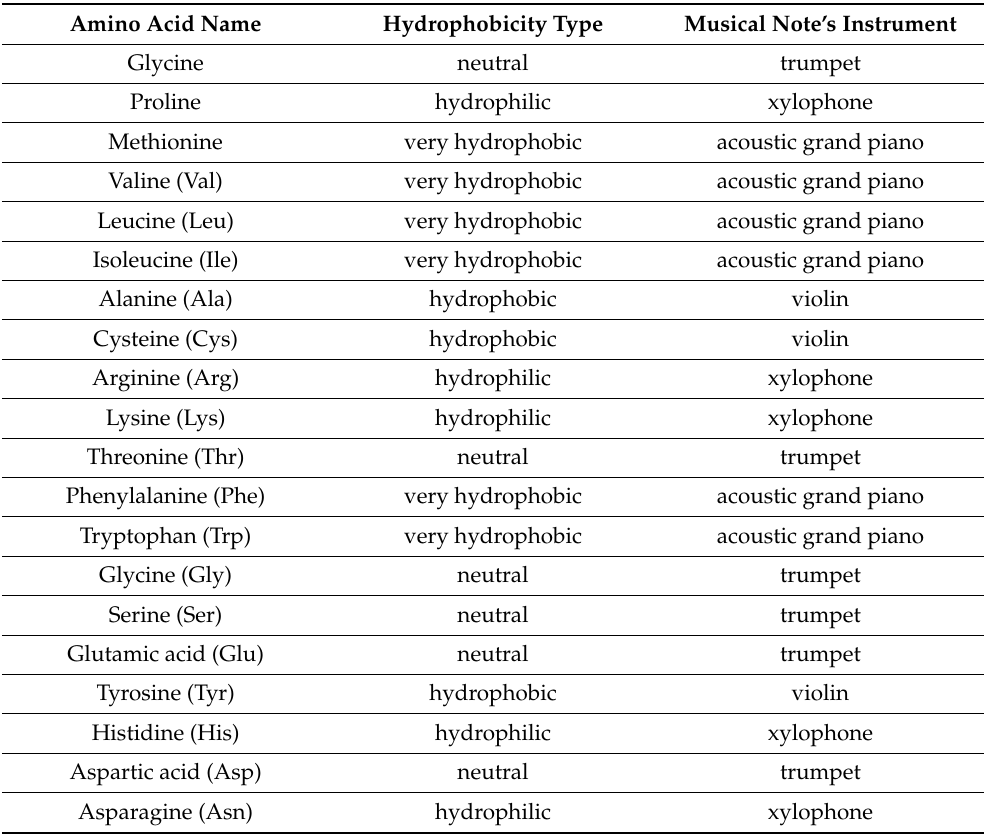
Table 1. Mappings among amino acids’ hydrophobicity [64] and musical